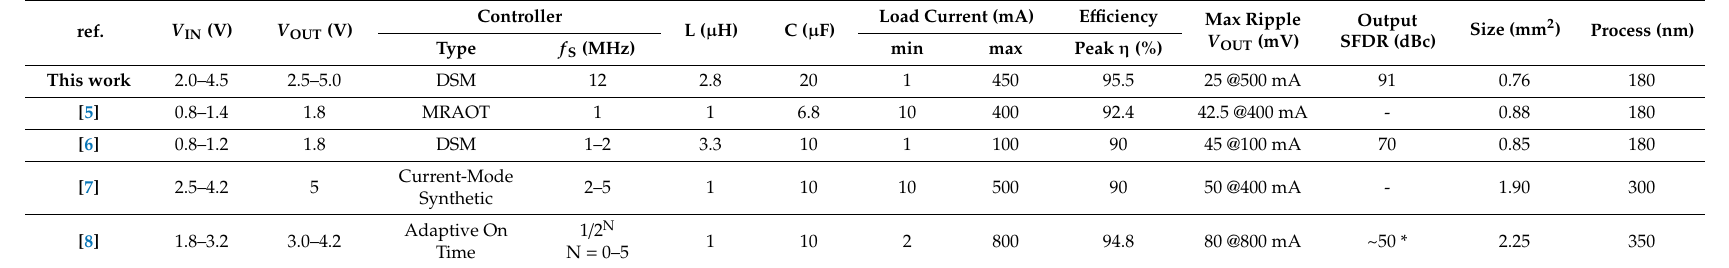
Table 1. Performance summary of the proposed converter and comparison with state-of-the-art boost converters.